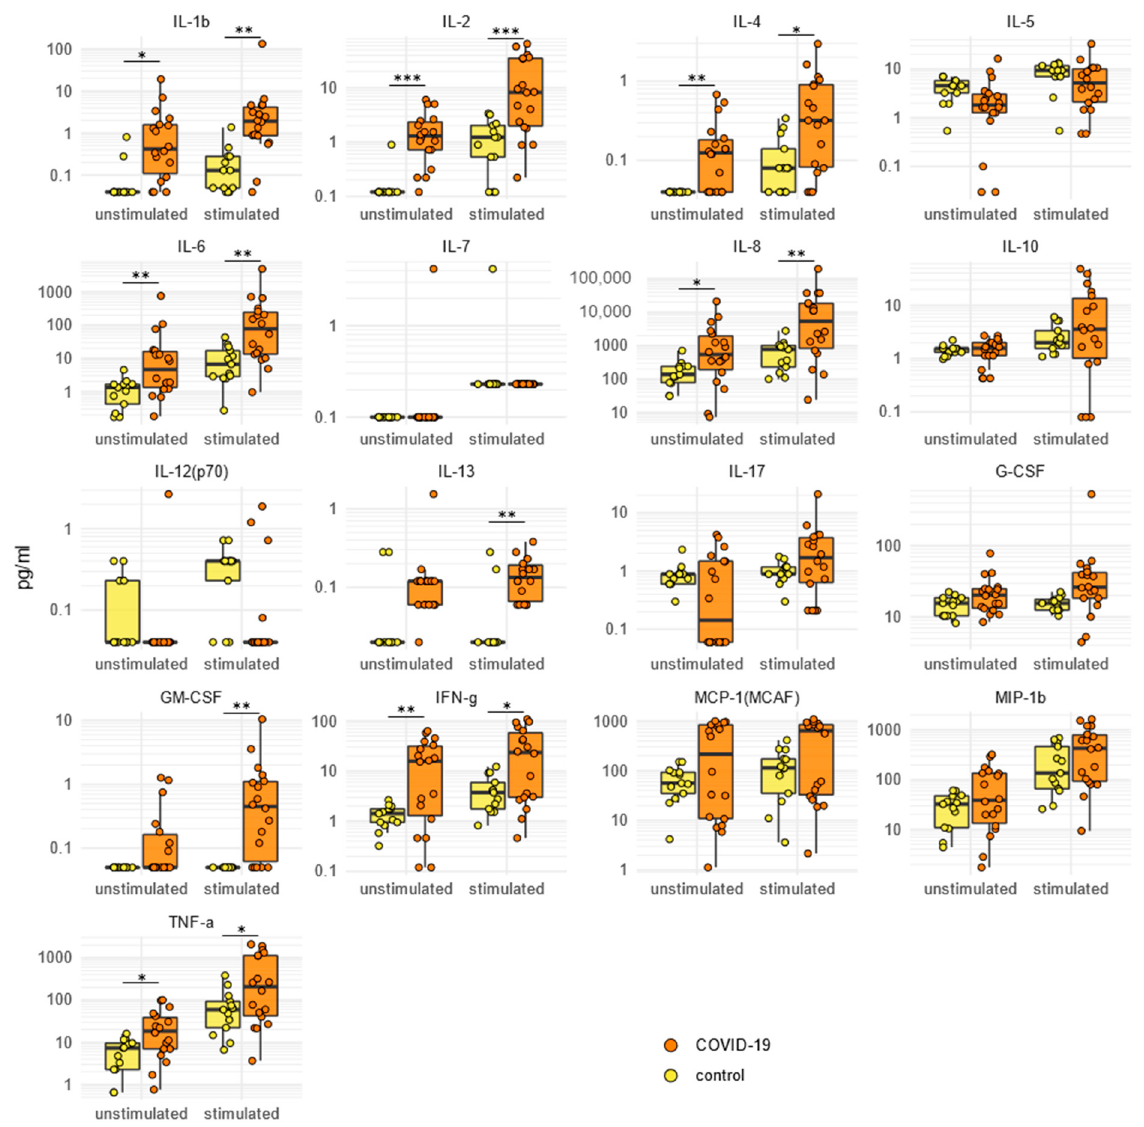
Figure 3. Cytokine and chemokine secretion by PBMCs upon SARS-CoV-2-antigen-specific stim- ulation. For each indicated cytokine or chemokine, results are shown for the control and patient secretions using unstimulated or SARS-CoV-2-stimulated PBMCs. Circles correspond to the levels of cytokines/chemokines secreted by the PBMCs of each subject. The value distributions are summa- rized as boxplots showing the median and interquartile range with whiskers extending to ± 1.96-fold the median. Significant differences between patient and control or unstimulated vs. stimulated secretions are indicated by asterisks (post hoc Tukey HSD test after repeated-measure ANOVA, p adjusted, *** p < 0.001, ** p < 0.01, * p < 0.05).